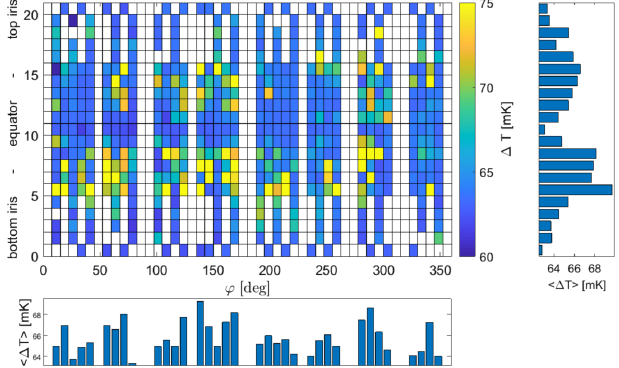
°.FIG. 12. Relative heating for applied field in α ¼ 90 °. The data ¼ 15 MW = m. The quality factor is recorded at 1.86 K, and E acc is Q 0 ¼ 4 . 4 × 10 9